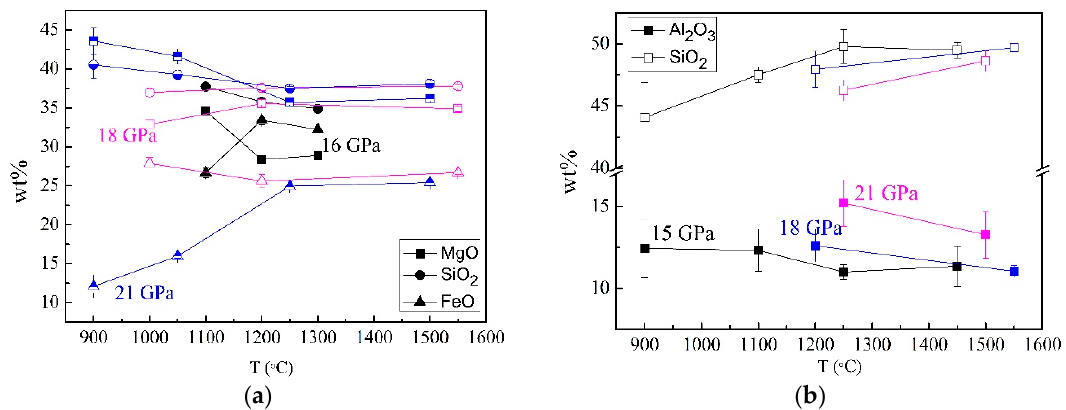
Figure 3. Chemical composition changes in ringwoodite ( a ) and garnet ( b ) with increasing temperature at di ff erent